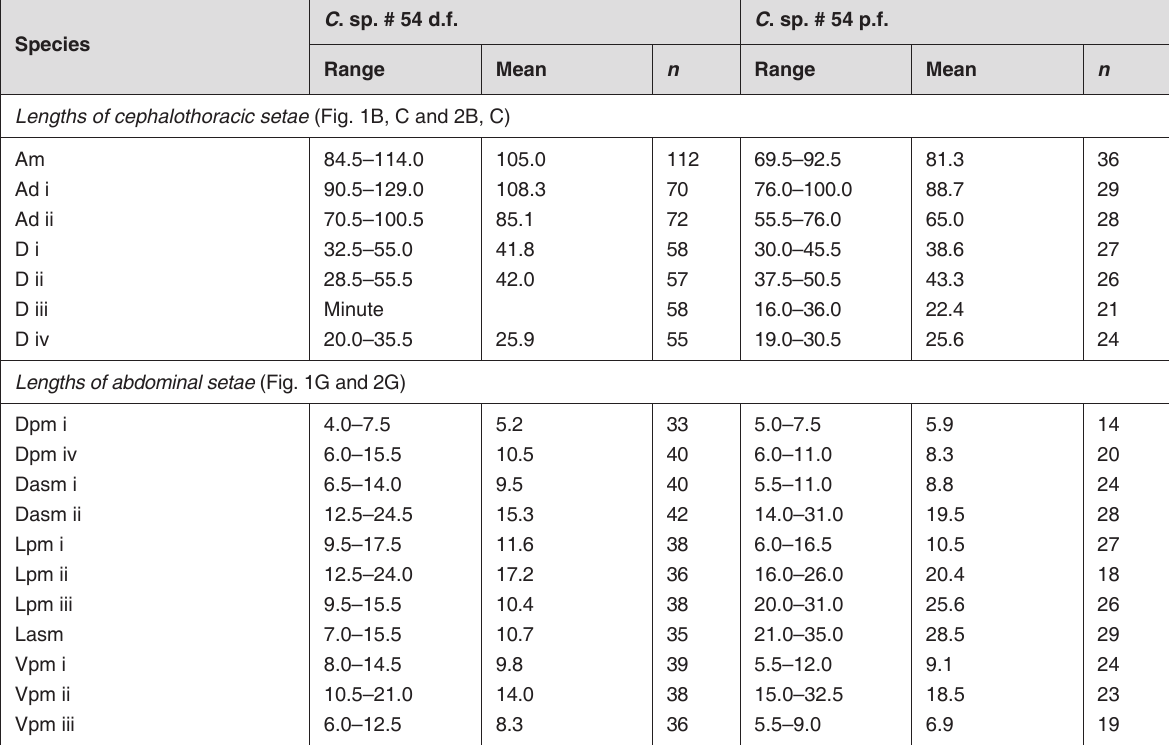
TABLE 2 Lengths (µm) of selected cephalothoracic and abdominal setae of the pupae of Culicoides sp. # 54 dark form and Culicoides sp. # 54 pale form